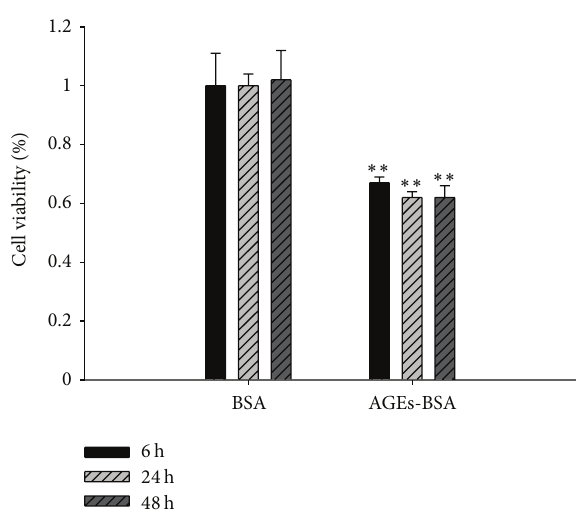
Figure 1: Effect of AGEs-BSA on cell viability determined by MTT test. HUVECs were treated with AGEs-BSA (100mg/L) or BSA (100mg/L) for 6 h, 24 h, 48 h. Viability was calculated as the percentage of living cells in treated cultures compared to those in control cultures. Each value represents the mean ± SD ( 𝑛 = 3 ). ∗ 𝑃 < 0.05, ∗∗ 𝑃 < 0.01 versus BSA group.